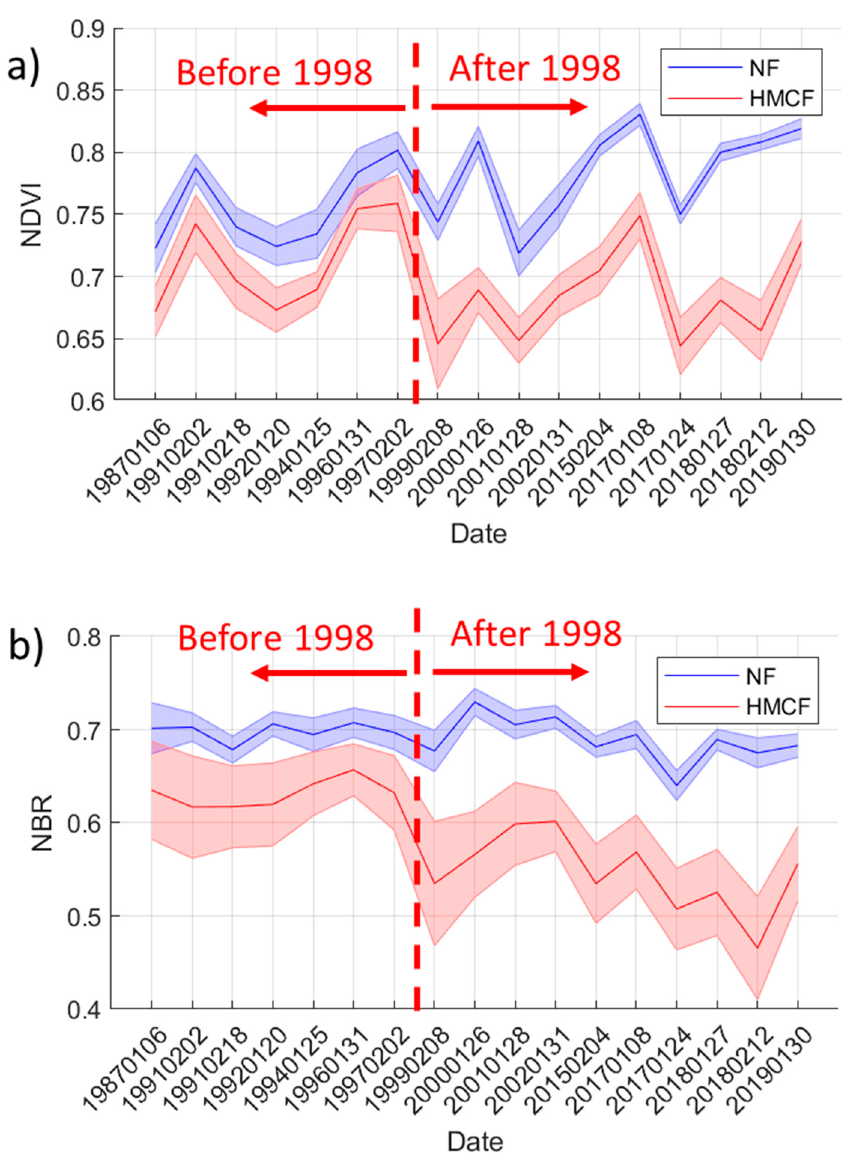
Figure 8. Temporal evolution of ( a ) NDVI and ( b ) NBR derived at the NF and HMCF sites. Dates are shown in year, month and day for the Landsat imagery used to derive NDVI and NBR. The thick blue line is the mean NDVI or NBR at the NF site, and the shaded area bounded by thin blue lines marks the upper and lower bounds of a SD of NDVI or NBR at the NF site. The thick red line is the mean NDVI or NBR at the HMCF site, and the shaded area bounded by thin red lines marks the upper and lower bounds of a SD of NDVI or NBR at the HMCF site.